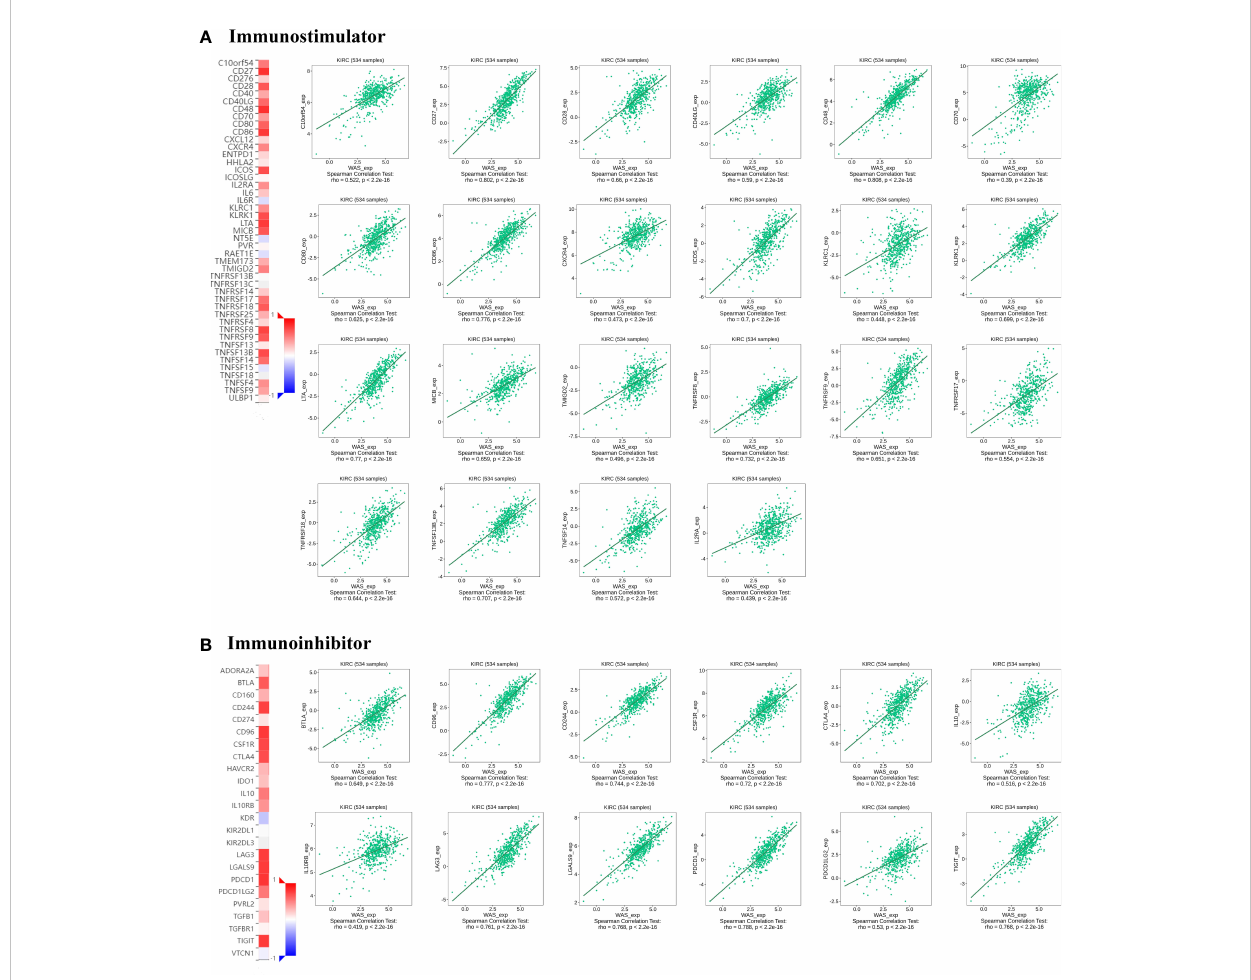
FIGURE 8 Correlation of WAS expression with immunomodulators in ccRCC. (A) Correlation between WAS expression and immunostimulants in ccRCC in the TISIDB database. (B) Correlations between WAS expression and immunoinhibitors in ccRCC a in the TISIDB